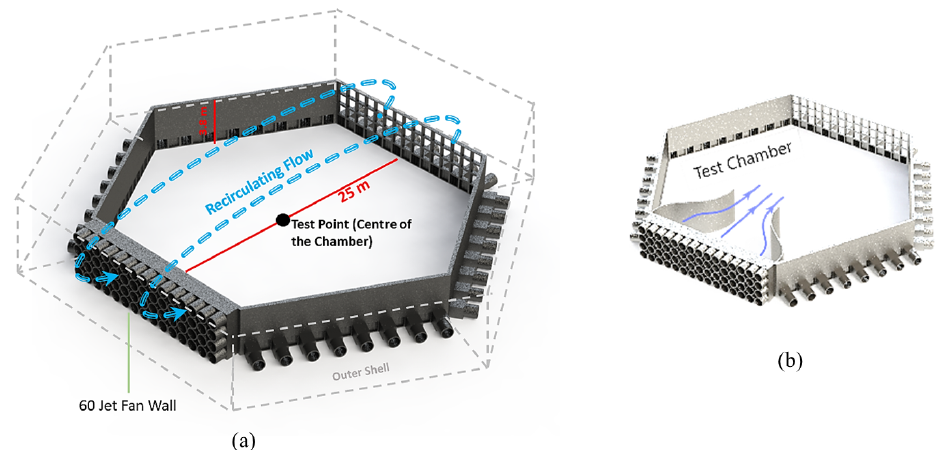
Figure 1. A brief geometry of the WindEEE dome: (a) the test chamber with outline of the outer shell along with the flow path in closed- circuit 2D flow mode and (b) the test chamber with contraction walls.